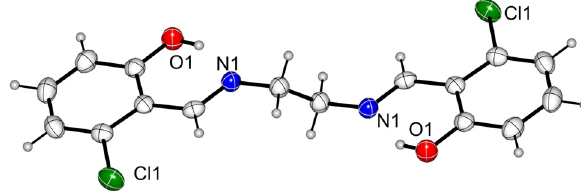
Table  : Data collection and handling.